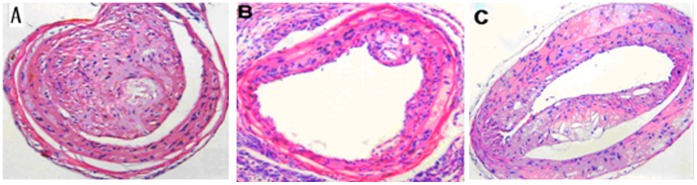
HE-stained cross sections of carotid 6 weeks in ApoE−/− mice injecting with anti-OX40(100 µg/ml) and anti-OX40L(100 µg/ml) 2 times a week.Representative of plaques in control(C) and treated with anti-OX40(A) and anti-OX40L(B) stained with HE.